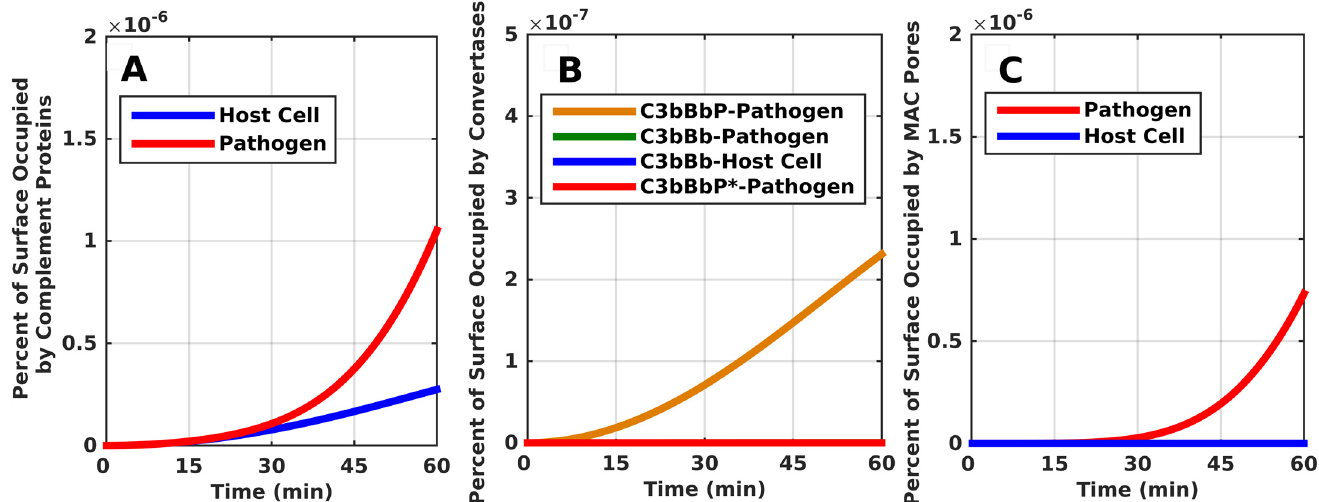
Fig 8. Time course for properdin (P * ) as a stabilizer and not an initiator of the alternative pathway. (A) More than 99 percent of pathogen surface remains unoccupied by complement components. (B, C) The C3 convertases and MAC pores occupy significantly less than 1 percent on pathogens and even less on host